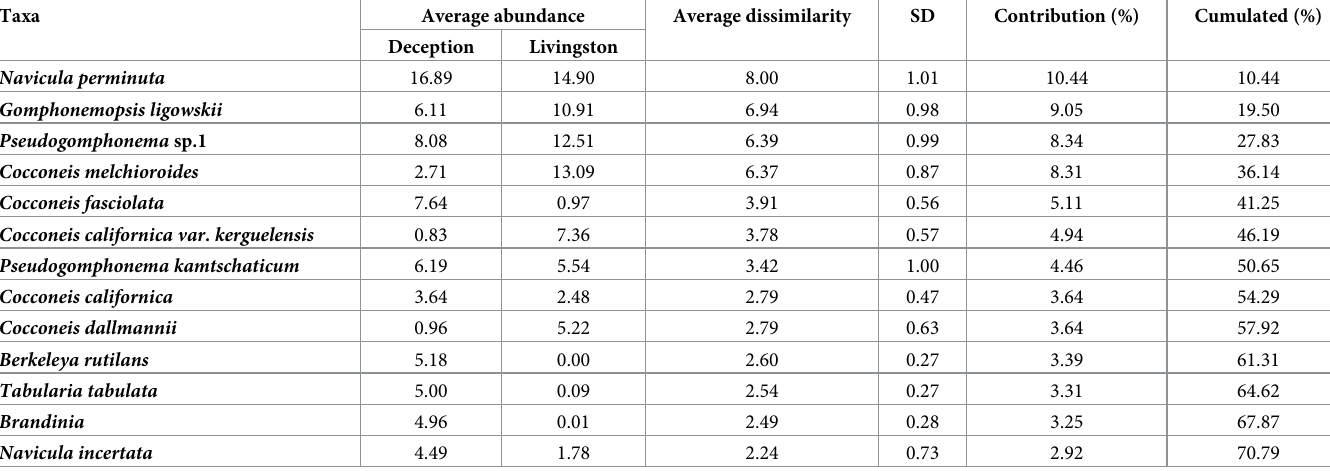
Table 6. Breakdown of average dissimilarity between epiphytic diatoms in Deception and Livingston Island locations (SIMPER). Taxa